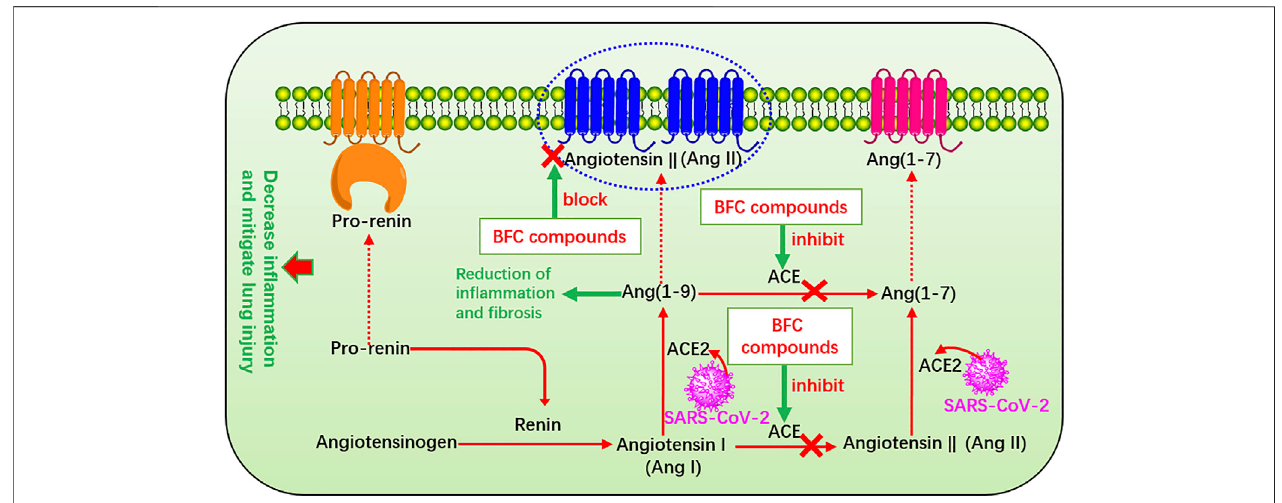
FIGURE 8 | The renin-angiotensin system (RAS) that BFC compounds in fl uence.